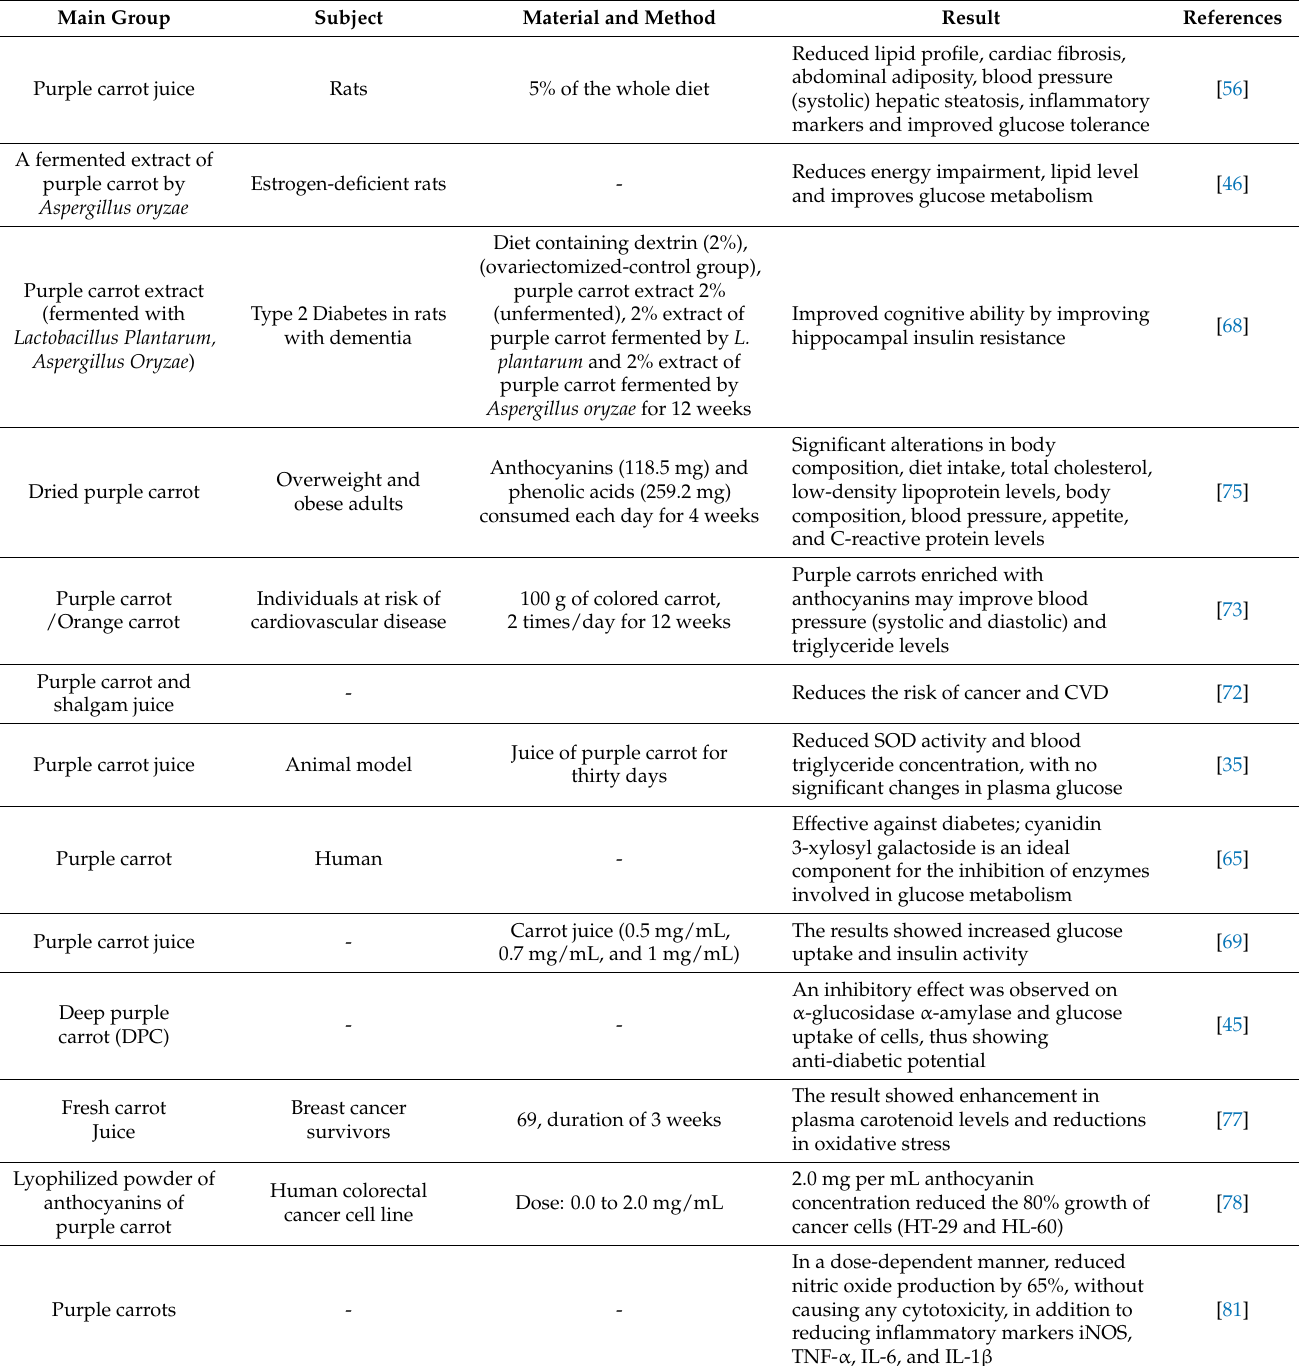
Table 4. The impact of purple carrot consumption with regard to MetS and